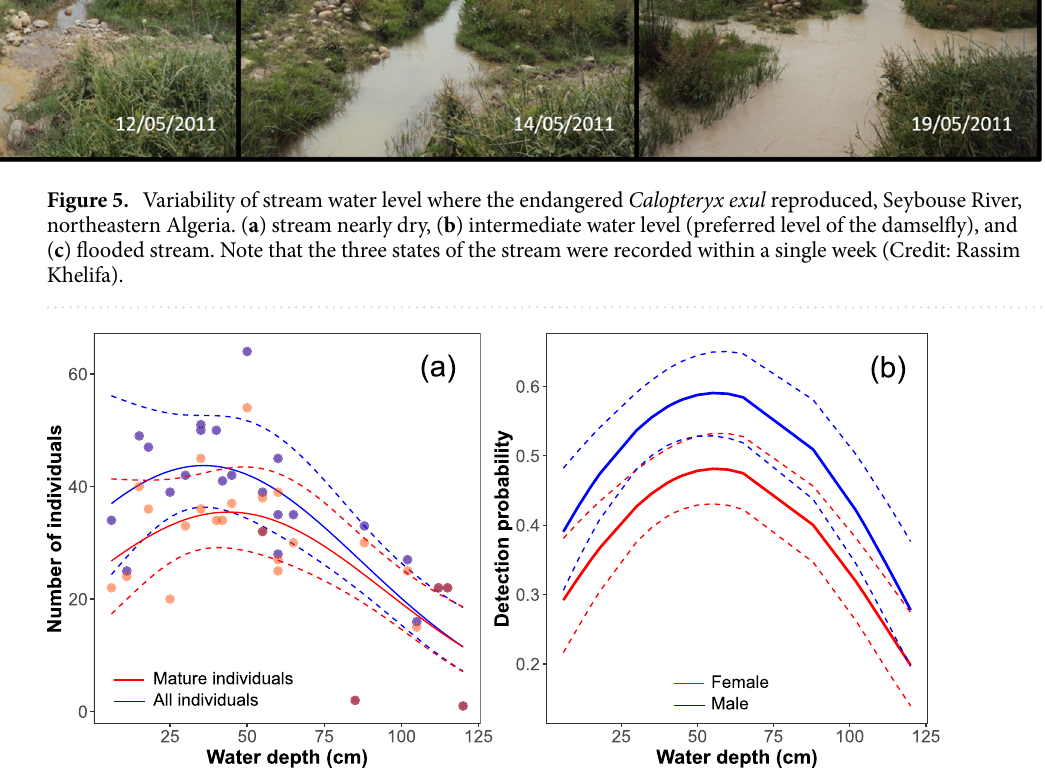
Figure 6. The effect of stream water depth on the number of adult individuals ( a ) and the recapture probability of marked male (blue) and female adults (red) of Calopteryx exul ( b ). ( a ) The fitted line is a negative binomial regression for all individuals (blue) and mature individuals only (red). ( b ) The fitted line is a prediction of a Cormack–Jolly–Seber model for capture–mark–recapture including a constant